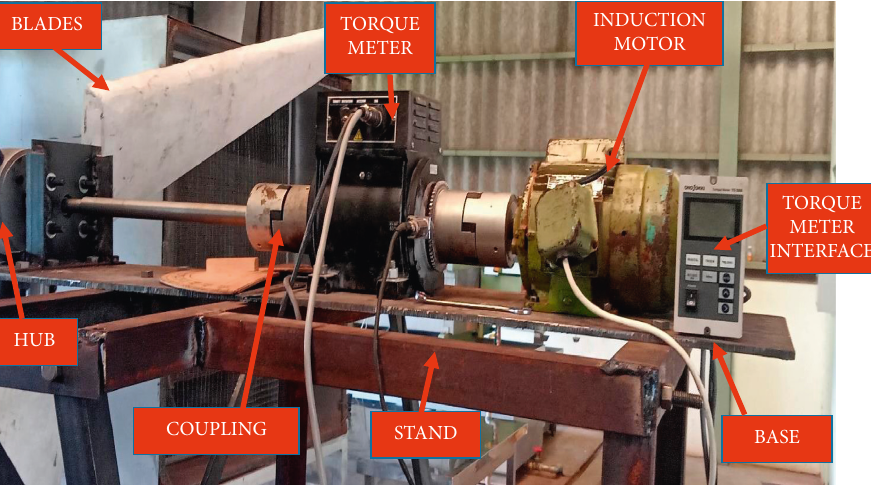
Figure 6: Wind turbine experimental setup.